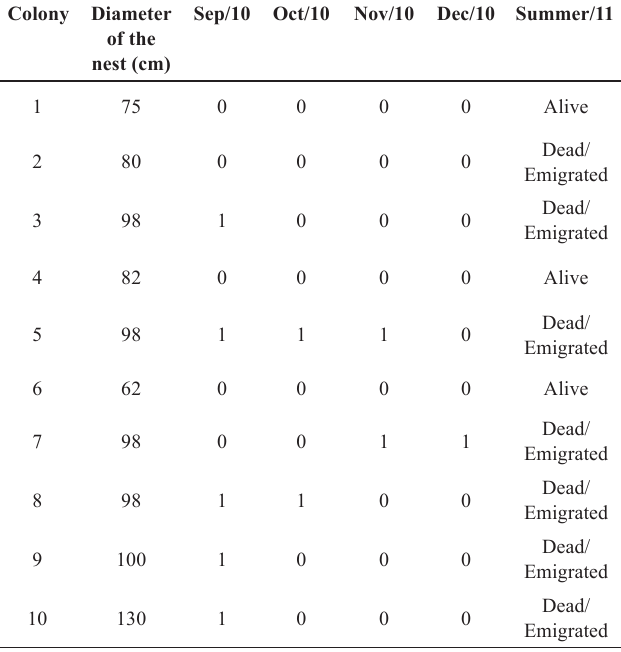
Table 2: Occurrence of reproductive ants (winged male or female ants) in Acromyrmex crassispinus